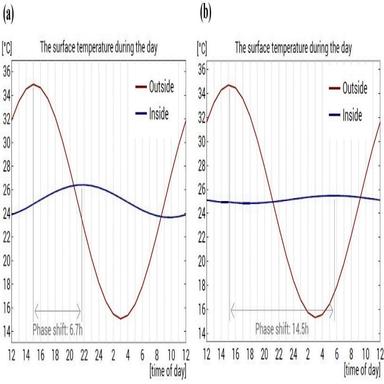
Surface temperature glass wool (a) and sawdust (b) during the day.